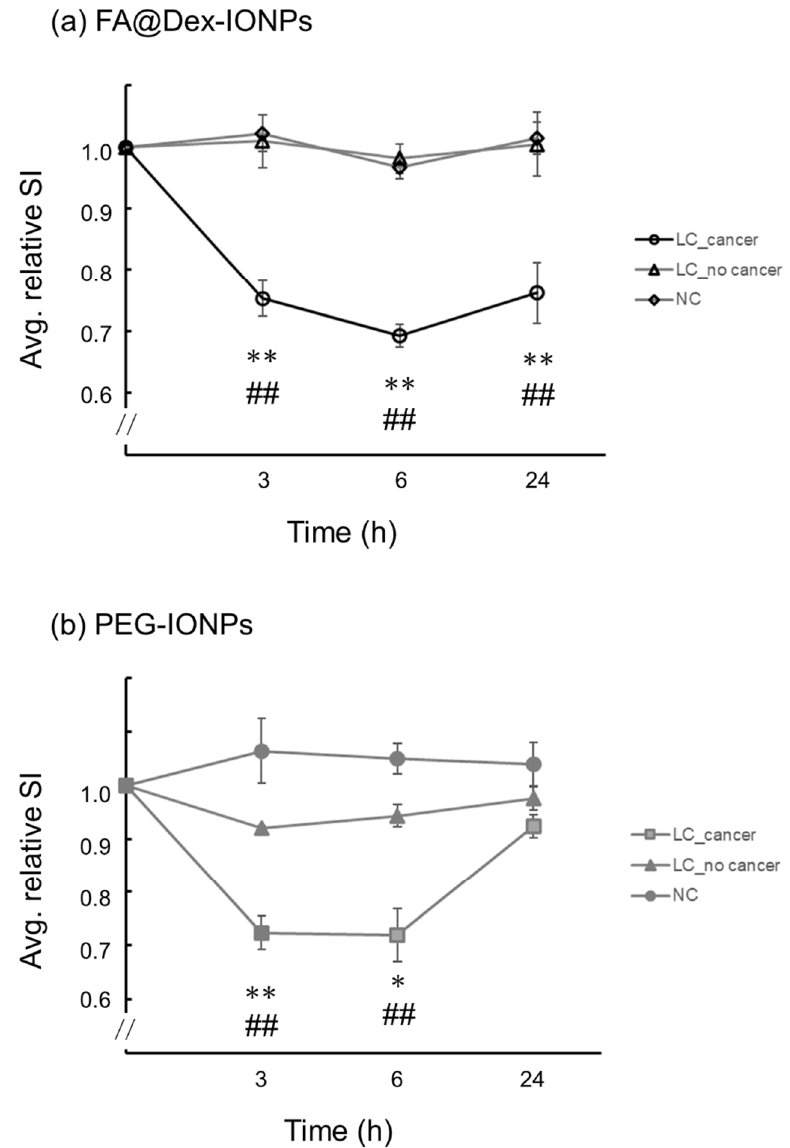
Figure 3. Plots of the temporal change of averaged relative signal intensity (Avg. relative SI) pre and post FA@Dex-IONPs ( a ) and PEG-IONPs ( b ) administration. The relative signal intensities were averaged for all ROIs LC_cancer , ROIs LC_no cancer , and ROIs NC . Data are represented by the mean ± SE. *: p < 0.05 between ROIs LC_cancer and ROIs LC_no cancer , **: p < 0.01 between ROIs LC_cancer and ROIs LC_no cancer , and ##: p < 0.01 between ROIs LC_cancer and ROIs NC . For FA@Dex-IONPs LC mice, the averaged relative signal intensities from ROIs LC_cancer were significantly lower at 3, 6, and 24 h post injection than those from ROIs LC_no cancer ( p < 0.01) and ROIs NC ( p < 0.01). Meanwhile, for PEG-IONPs LC mice,